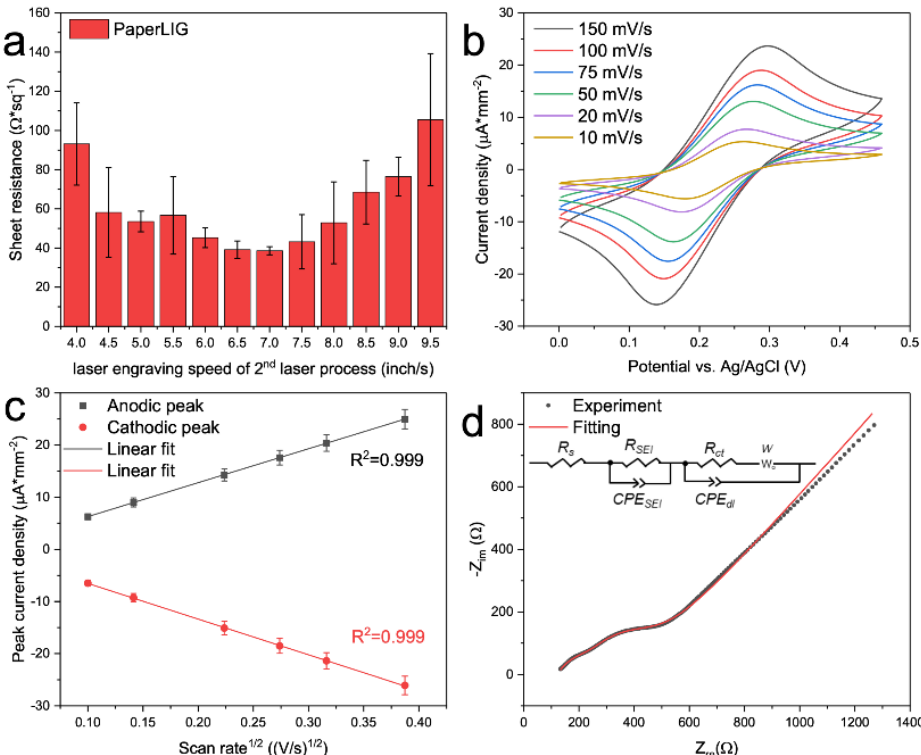
Figure 3. ( a ) Sheet resistance measurement of PaperLIG ( n = 10) fabricated with various laser en- graving speeds of second laser processing. ( b ) Cyclic voltammetry of PaperLIG electrode in the PBS solution containing 5 mM K 3 Fe(CN) 6 /K 4 Fe(CN) 6 with 0.1 M KCl under different scan rates (10–150 mV/s). ( c ) The plot of peak current density ( n = 10) versus the square root of the scan rate for the CV of PaperLIG electrodes ( b ). ( d ) Nyquist plot of EIS of PaperLIG electrode in the PBS solution containing 5 mM K 3 Fe(CN) 6 /K 4 Fe(CN) 6 with 0.1 M KCl. The inset shows the equivalent circuit used for fitting the experiment